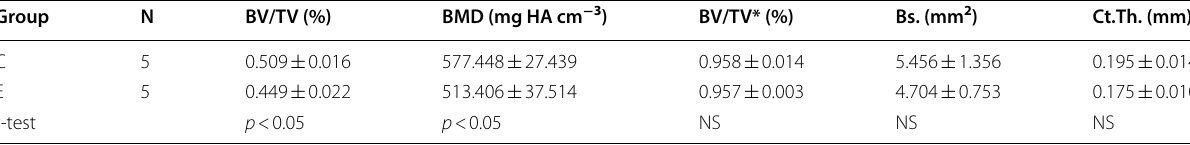
n number of measurements, NS non-significant differences, BV/TV relative bone volume, BMD bone mineral density, BV/TV* relative bone volume without marrow cavity, Bs . bone surface, Ct.Th. cortical bone Quantitative 3D analysis of trabecular bone tissue